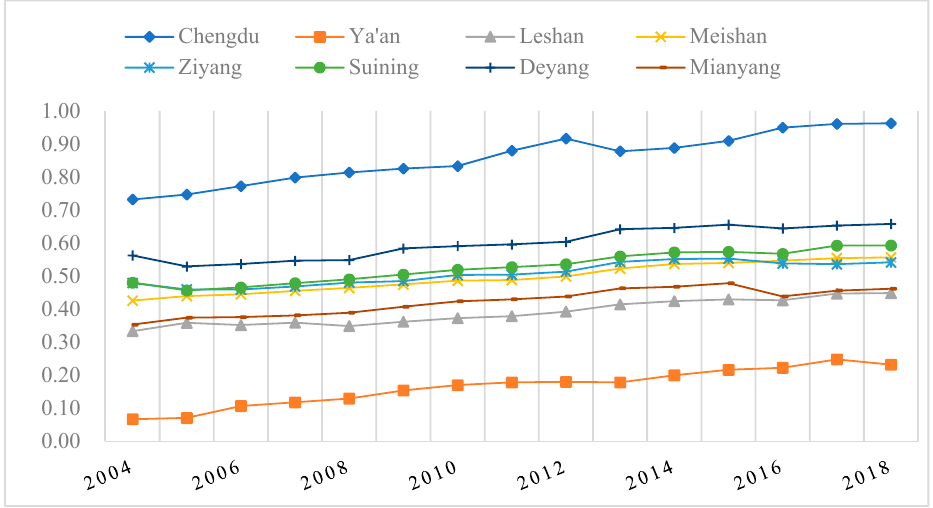
Figure 6. Coupling coordination degree from 2004 to 2018.